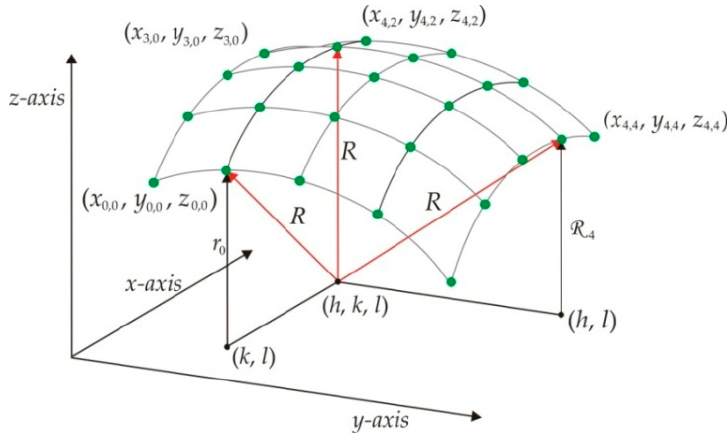
Figure 1. Rectangular spherical surface to perform spherical surface modeling. The spherical origin coordinates are represented by ( h , k , l ) and the ratio is represented by R . Furthermore, the spherical surface provides the ratio r i in the x -axis and the ratio R j in the y -axis. The coordinates ( k , l ) and ( h , l ) represent the origin coordinates of the ratios r i and R j , respectively. Based on these coordinates, the spherical surface model is defined via ratio R by means of the next expression